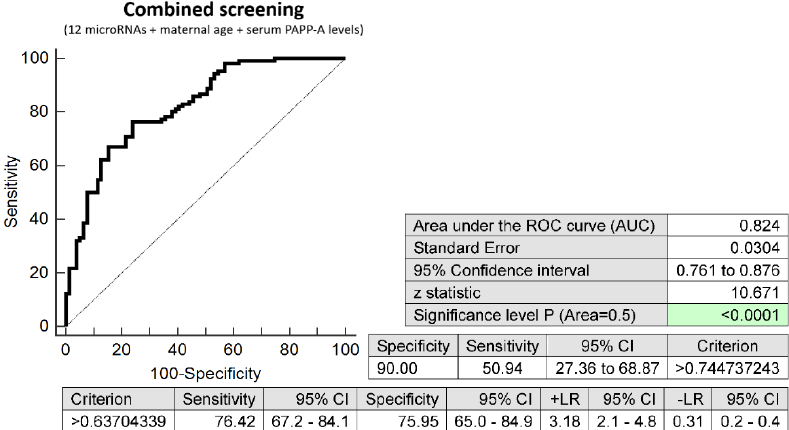
Figure 3. ROC analysis—combination of 12 microRNA biomarkers, maternal age at sampling and serum PAPP-A levels (IU/L) in early prediction of preterm delivery. The combination of 12 microRNAs (miR-16-5p, miR-20b-5p, miR-21-5p, miR-24-3p, miR-26a-5p, miR-92a-3p, miR-133a- and serum PAPP-A levels (IU/L) was able to predict at 10.0% FPR the occurrence of preterm delivery in 50.94%